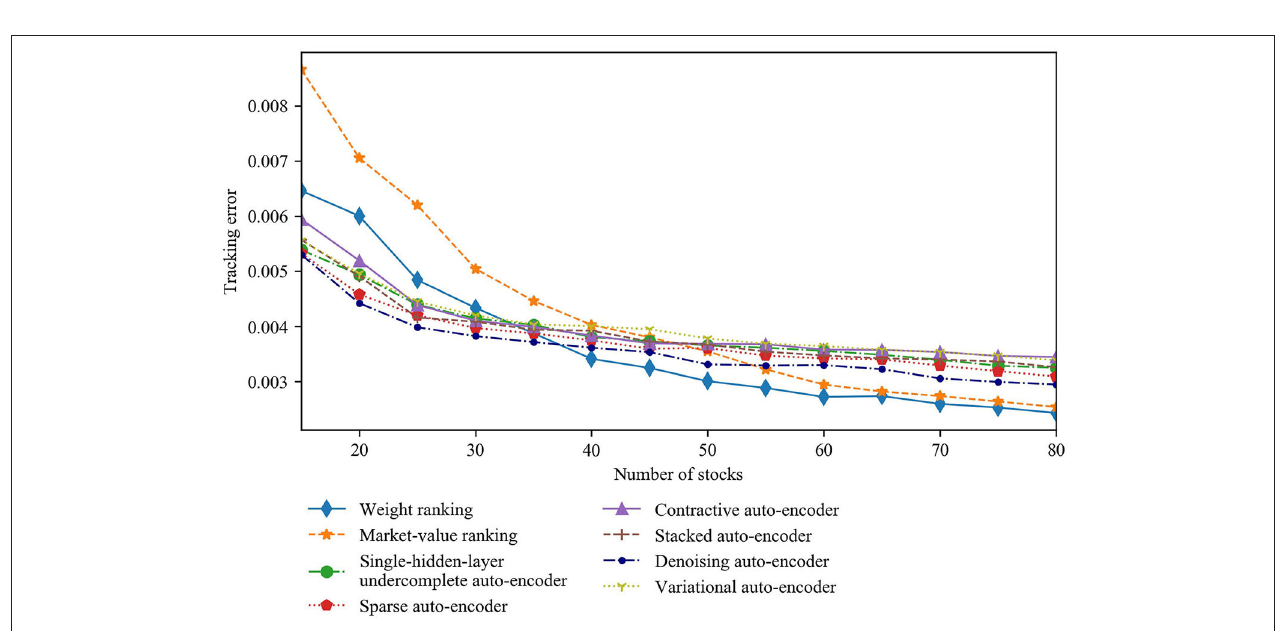
FIGURE 15 | Tracking error curves for all strategies with yearly rebalancing.